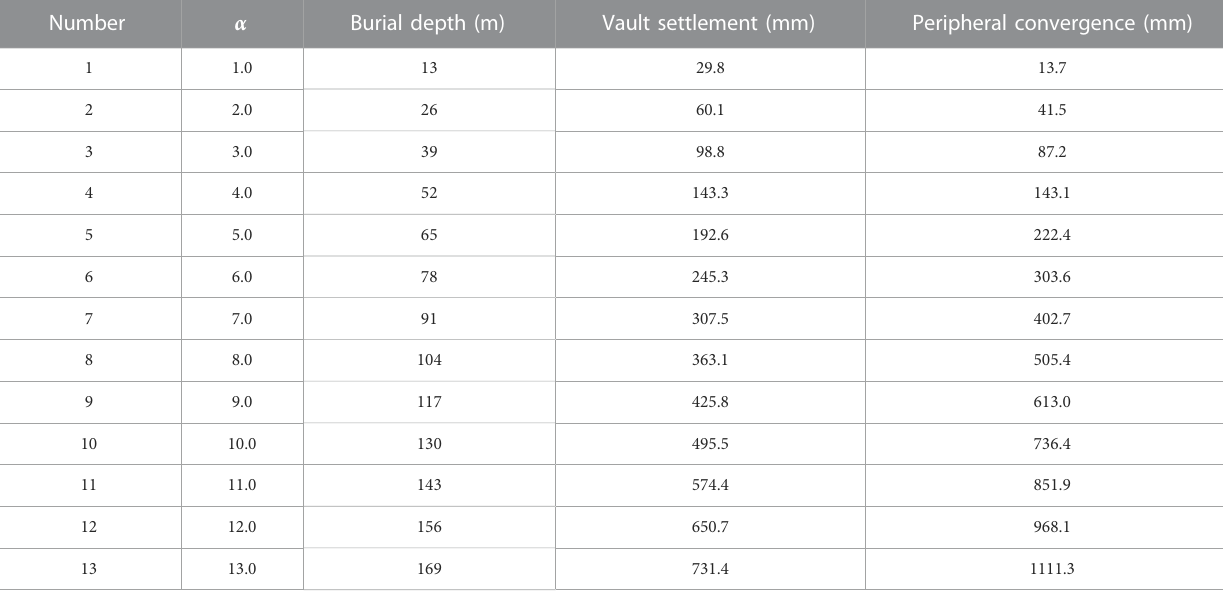
TABLE 2 Calculation results of vault settlement and peripheral convergence of the surrounding rock at different burial depths. Number α Burial depth (m) Vault settlement